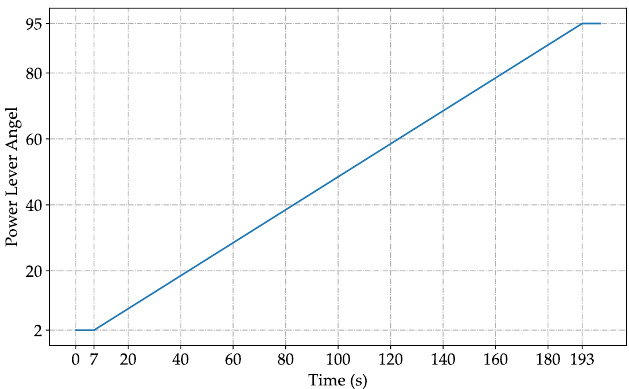
Figure 2. The PLA used by the model to generate the